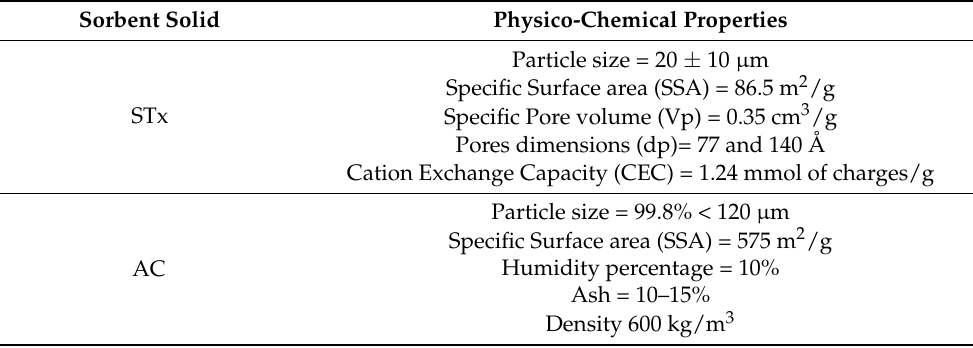
Table 1. Physico-chemical properties of pristine clay (STx) and activated carbon